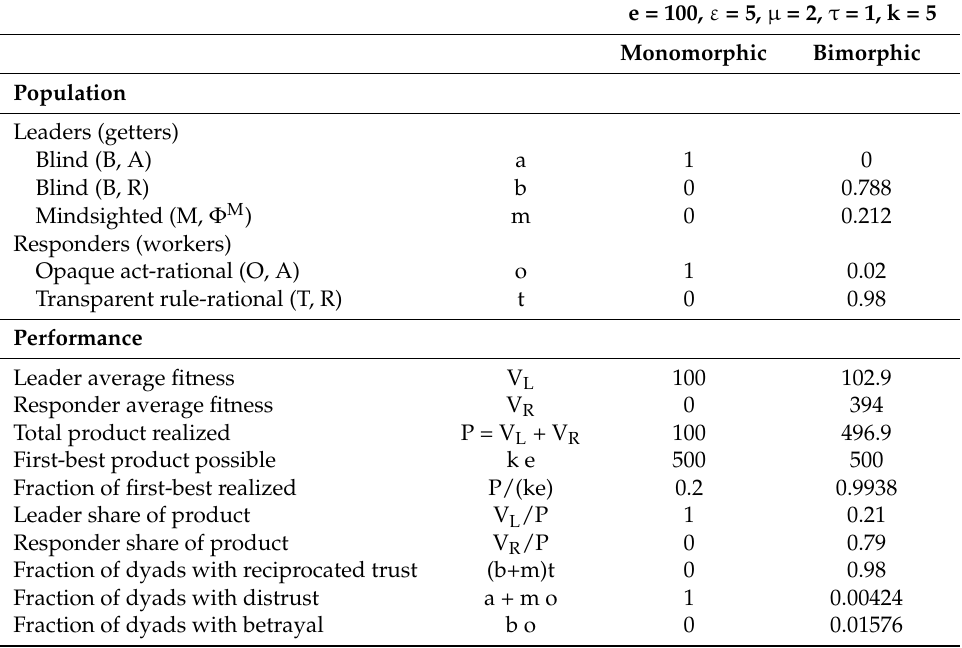
Table 2. Economic performance in the Trust game in the monomorphic equilibrium consisting solely of act-rational agents without mindsight or transparency, and at the bimorphic rest point where act- and rule-rational agents